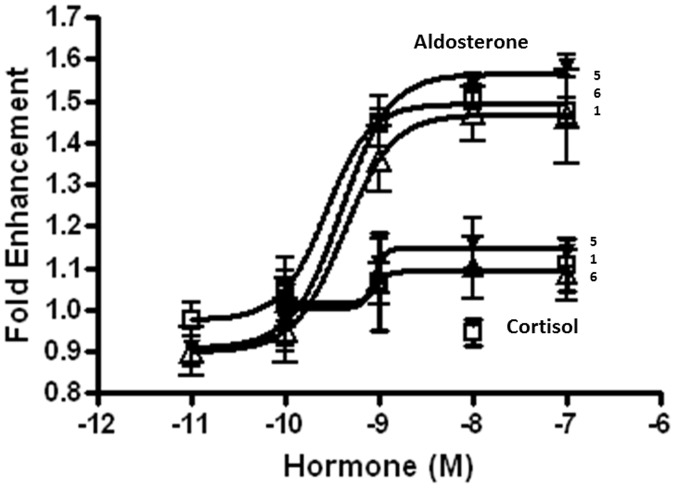
Effect of mineralocorticoid receptor (MR) and aldosterone in HEK293T cells expressing Kcnn4 genomic clone.Regions of the Kcnn4 genes showing positive response in a ChIP assay and indicated by bars in Figure-1C (clone-1, clone-3, clone-5, clone-6, clone-7 and clone-8) were sub-cloned in pGL4.23 and tested for the presence of MR/aldosterone (mineralocorticoid)-responsive enhancers (MRE). The HEK293T cells were transfected with pGL4.23 or pGL4.23 containing Kcnn4 genomic clones. The cells transfected with Kcnn4 genomic clones were also transfected with MR. Luciferase activity was measured in the cells transfected with the Kcnn4 genomic clones with (hatched bars) and without (grey bars) MR transfection. The luciferase activity in the cells transfected with the Kcnn4 genomic clones and MR was also measured in the presence of 10 nM aldosterone (black bars). For clarity, luciferase activity measured in the presence of a plasmid, MR and aldosterone are shown in cells transfected with pGL-4.23, clones-3, -5 and -6. Results presented represent mean ± SE from 3 different experiments. *p<0.05– compared to pGL4.23.